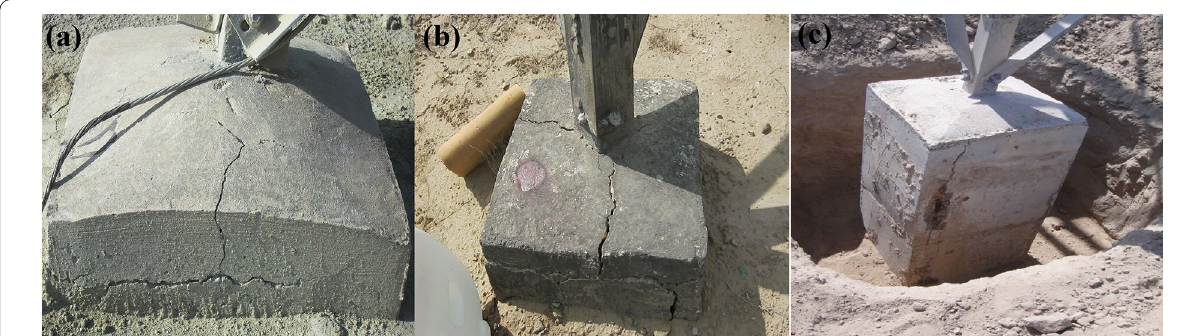
Fig. 2 Corrosion-affected zones of electric transmission tower foundations.